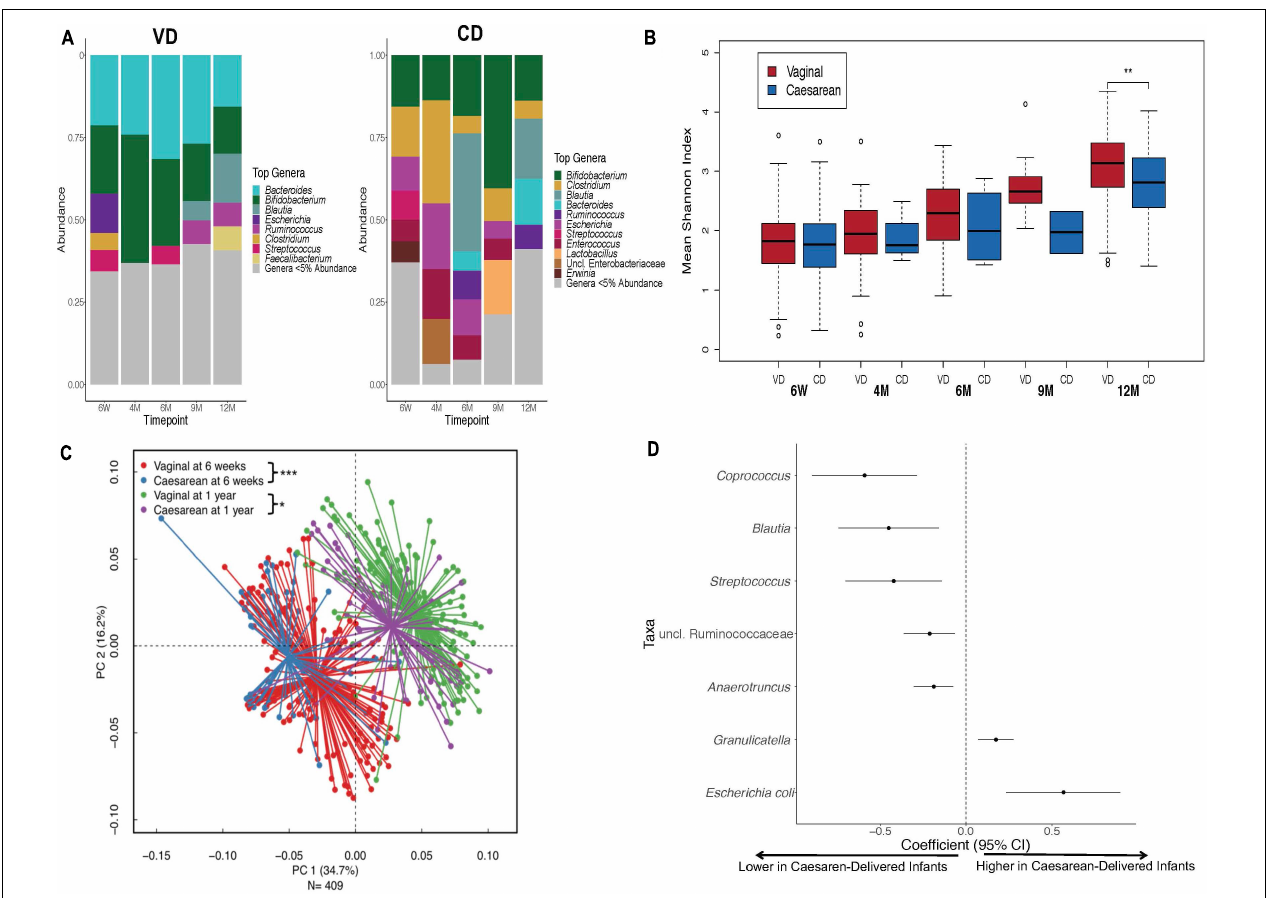
FIGURE 1 | Distinct 16S microbial signatures based on birth mode in the First year of life. (A) Stacked bar charts illustrating relative abundance of predominant genera ( ≥ 5% relative abundance) at each period of sample collection by delivery mode. (B) Shannon diversity indices was significantly higher for the VD group at 1 year only, however, diversity indices were consistently lower for the CD group throughout the First year of life. (C) Infant stool community composition differ based on delivery mode over the course of the study period. Beta diversity, generalized Unifrac adjusted group differences between CD and VD infants met the significance threshold at 6 weeks and 1 year. (D) Differentially abundant taxa based on delivery mode. * p < 0.05, ** p < 0.01, *** p < 0.001, NS not significant. VD, vaginally delivered; CD, cesarean